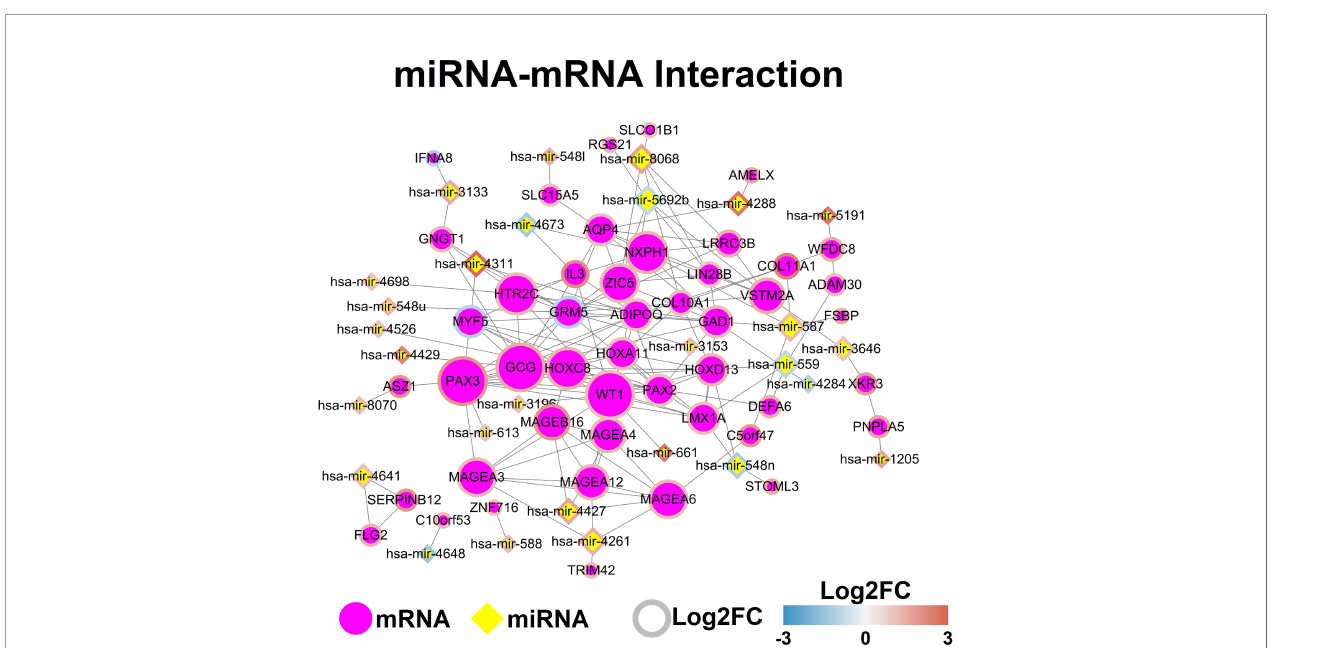
FIGURE 3 | MiRNA-mRNA network. Each node represents one genes, and ach edge represents the interaction between genes. MiRNAs and mRNAs are indicated using diamond shapes and circle shapes respectively.